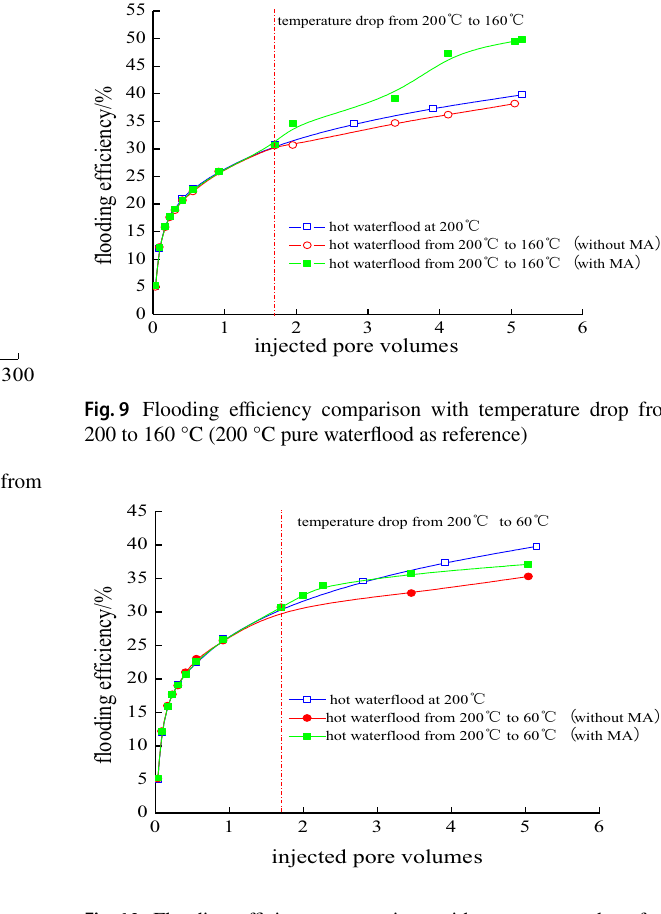
Fig. 10 Flooding efficiency comparison with temperature drop